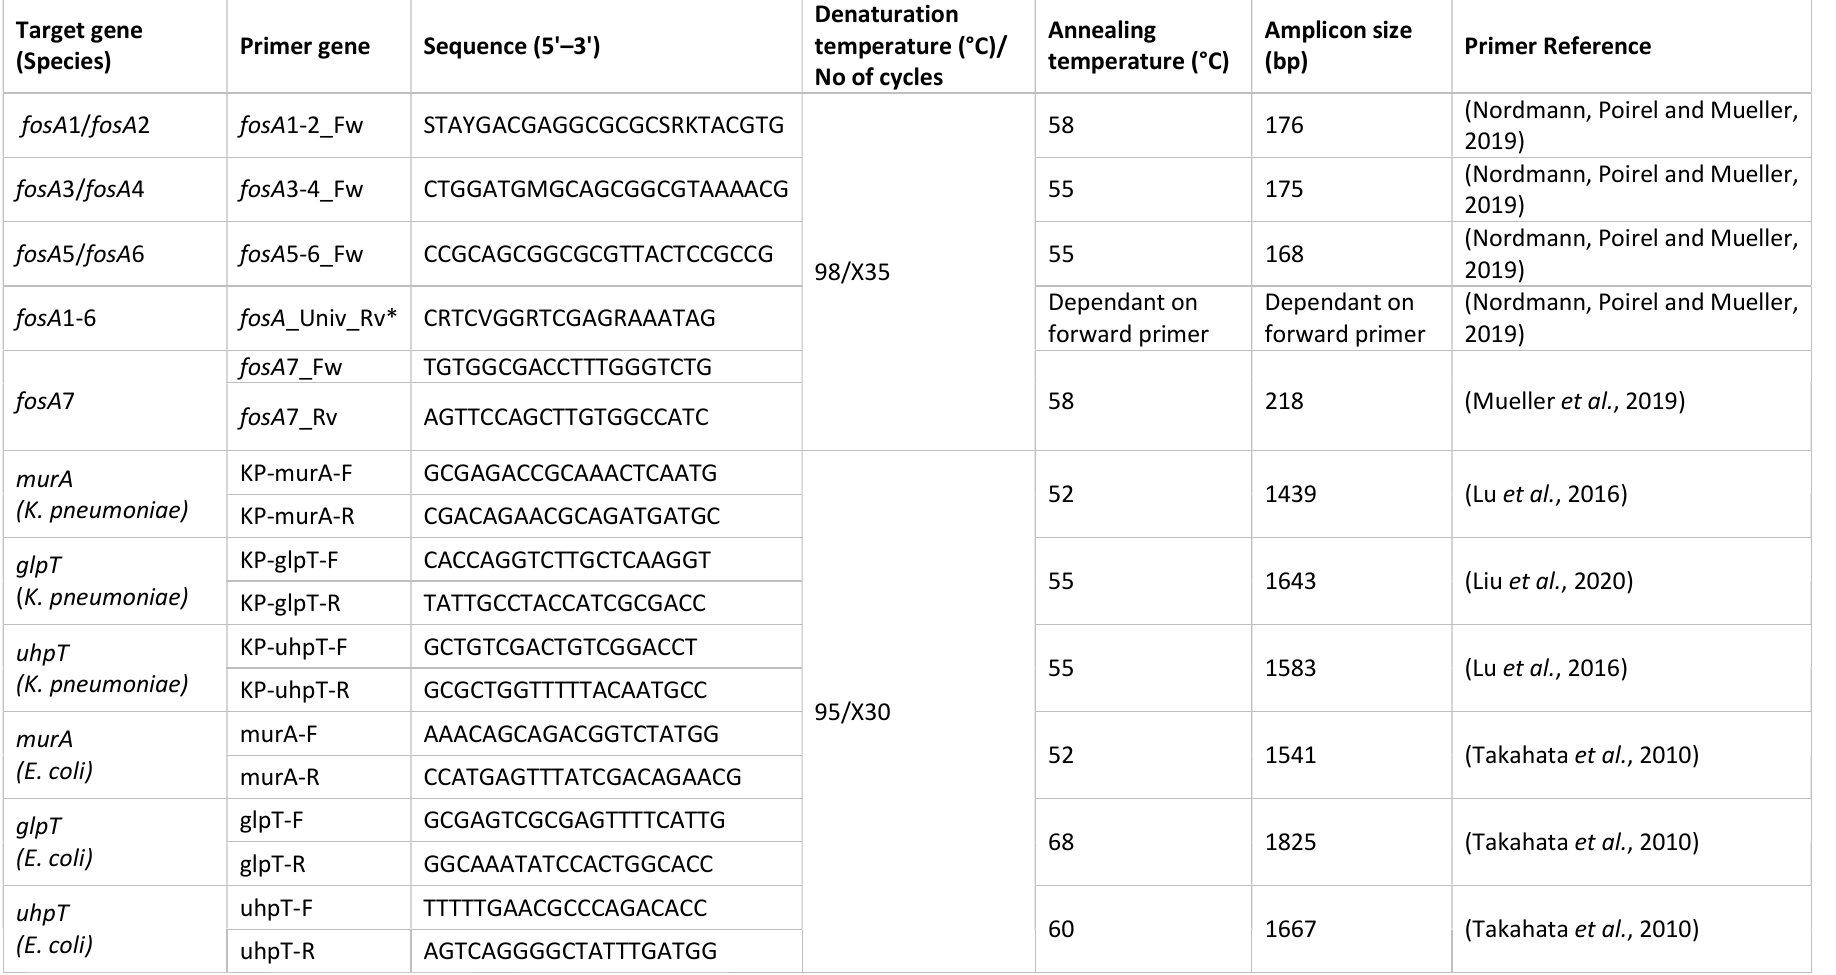
TABLE 1-A1 : Primer sequences and reaction conditions used for